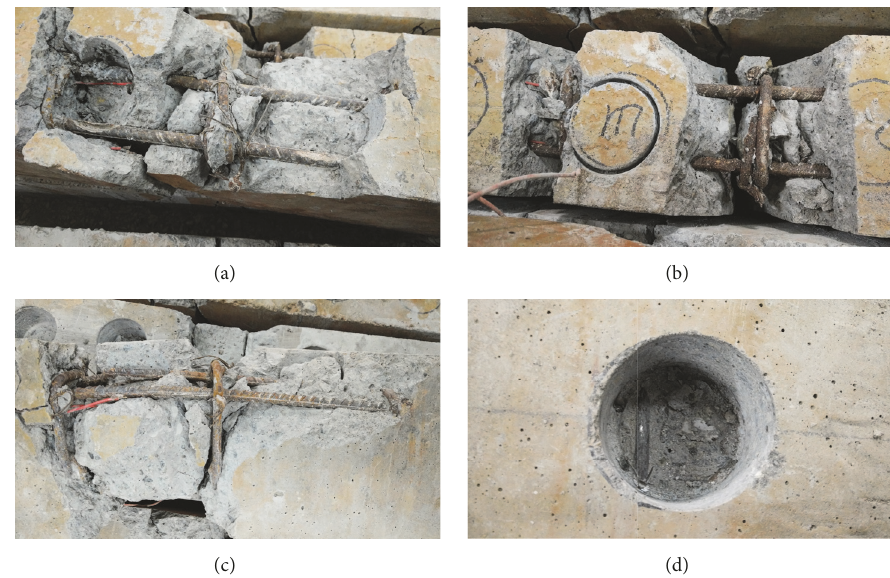
Figure 14: Corrosion of steel reinforcement in concrete ((a), (b), (c)) crack region and (d) uncracked region.